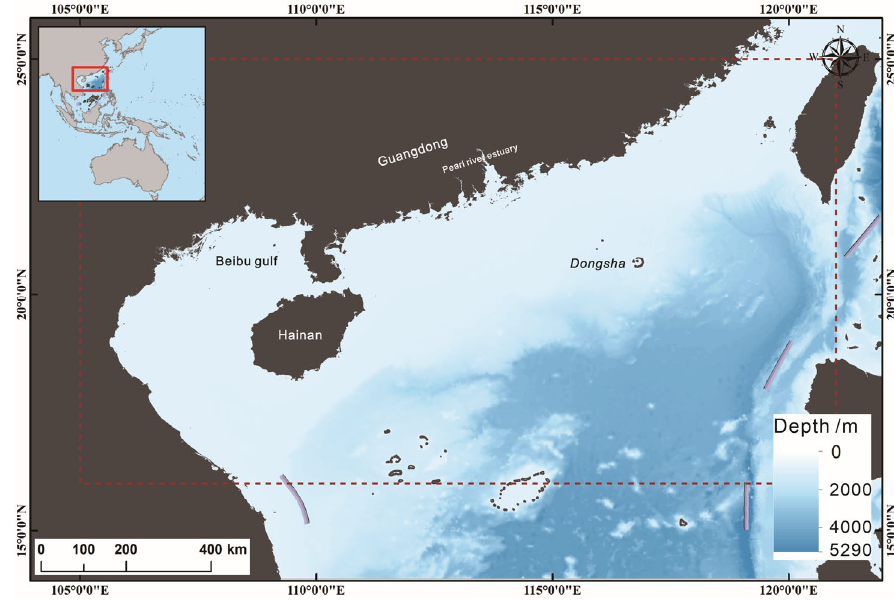
Figure 1. The study area (longitude ~105°–121°E, latitude ~16°–25°N).